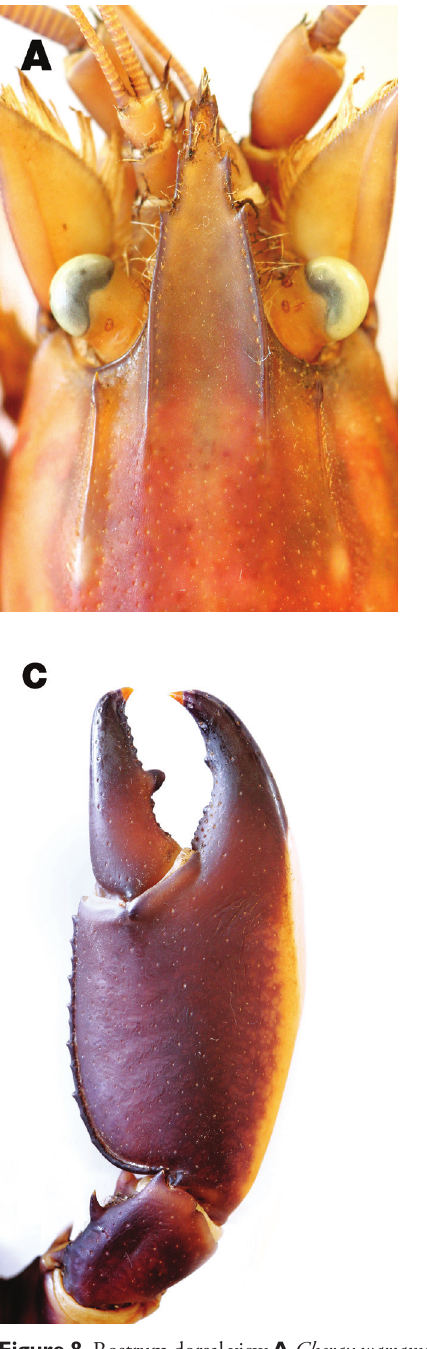
Figure 8. Rostrum dorsal view A Cherax warsamsonicus sp. n., holotype male, (MZB Cru 4529) B Cherax misolicus ( NMB 956a) C Cherax warsamsonicus sp. n right first chela, dorsal aspect D Cherax misolicus right first chela, dorsal